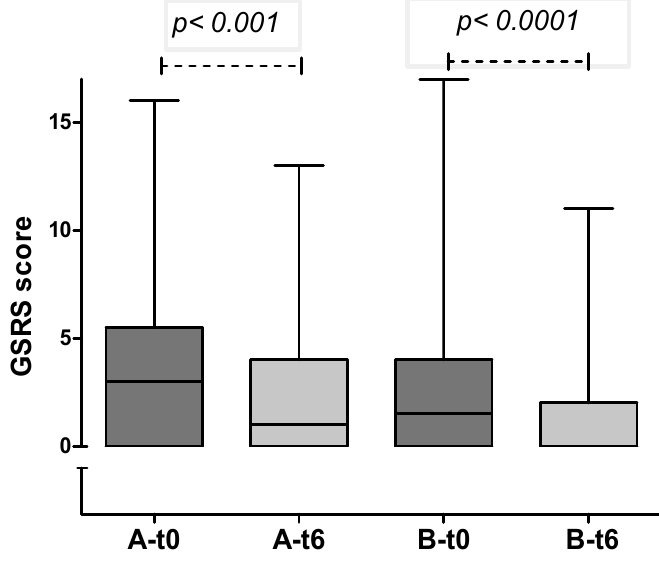
Figure 2. GSRS score in group A and B at enrollment and after 6 months (median and IQR): in both groups a significant reduction in GI symptoms was observed.